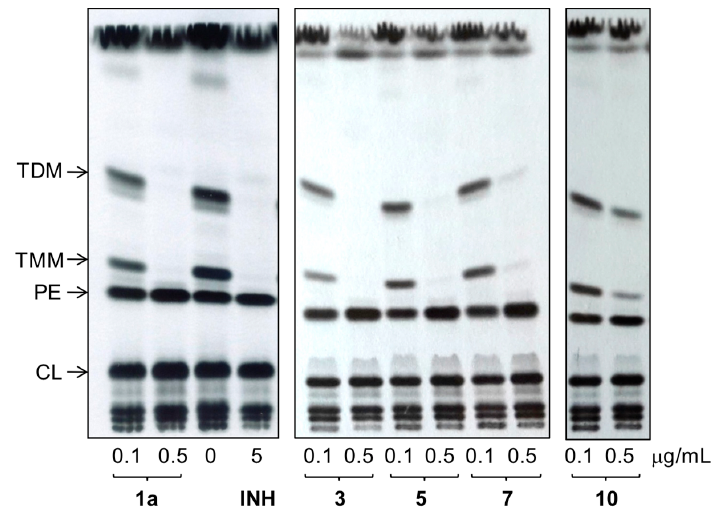
Figure 6. TLC analysis of lipids extracted from 14 C acetate labeled M.tb H37Ra cells treated with compounds 1a , 3 , 5 , 7 and 10 , INH and DMSO as a control. Lipids were separated in chloroform:methanol:water (20:4:0.5) and detected by autoradiography (TDM: trehalose dimycolates; TMM: trehalose monomycolates; PE: phosphatidylethanolamine; CL: cardiolipin).